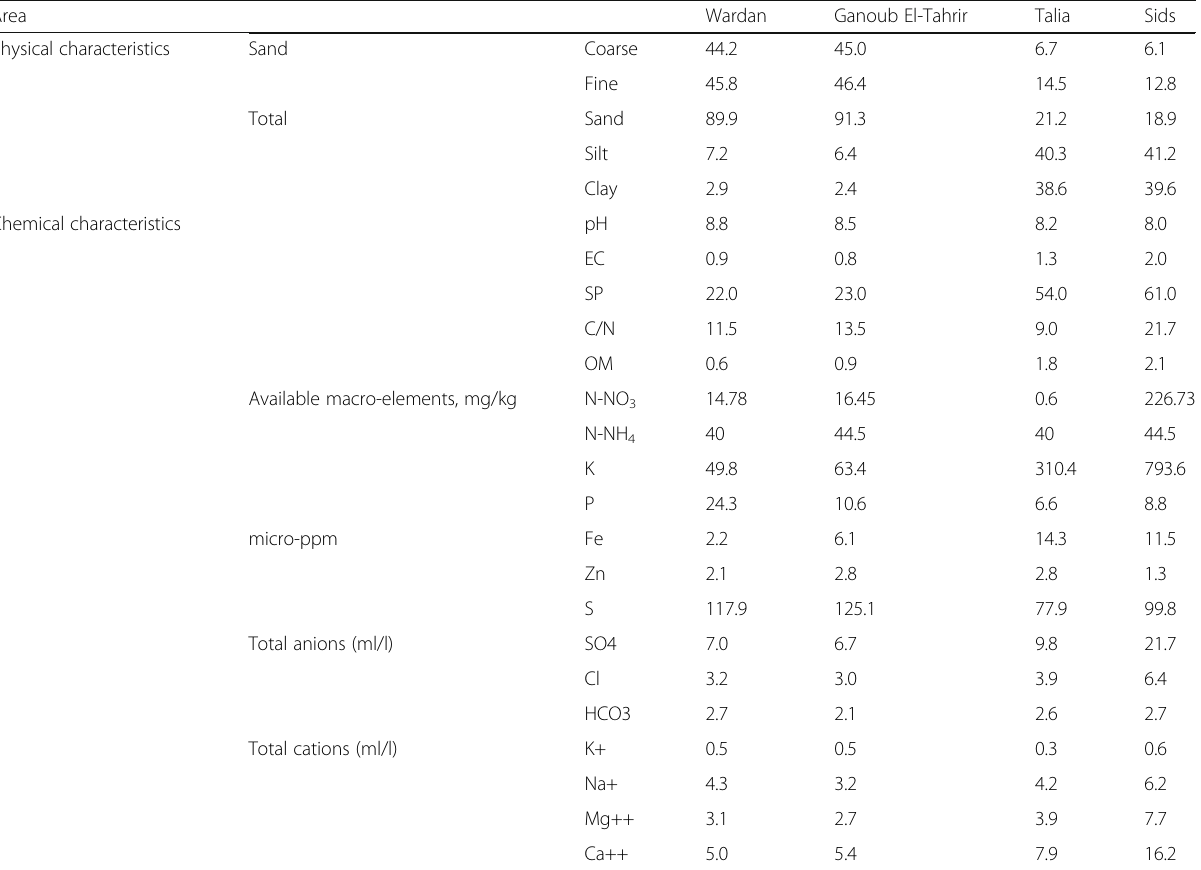
Table 2 Physical and chemical soil characteristics for different soils before starting the crop succession program Area Wardan Ganoub El-Tahrir Physical characteristics